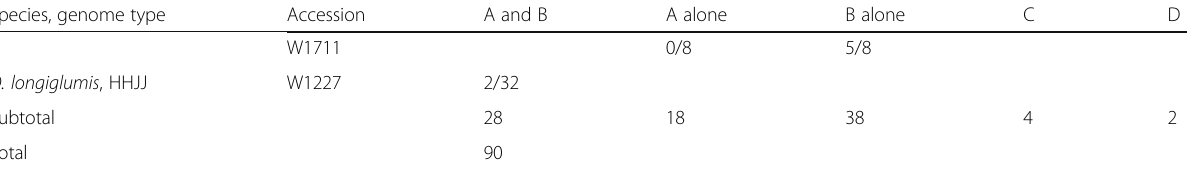
Table 2 Regeneration from immature embryos of wild Oryza accessions on 4 medium combinations (A – D) (Continued) Species, genome type